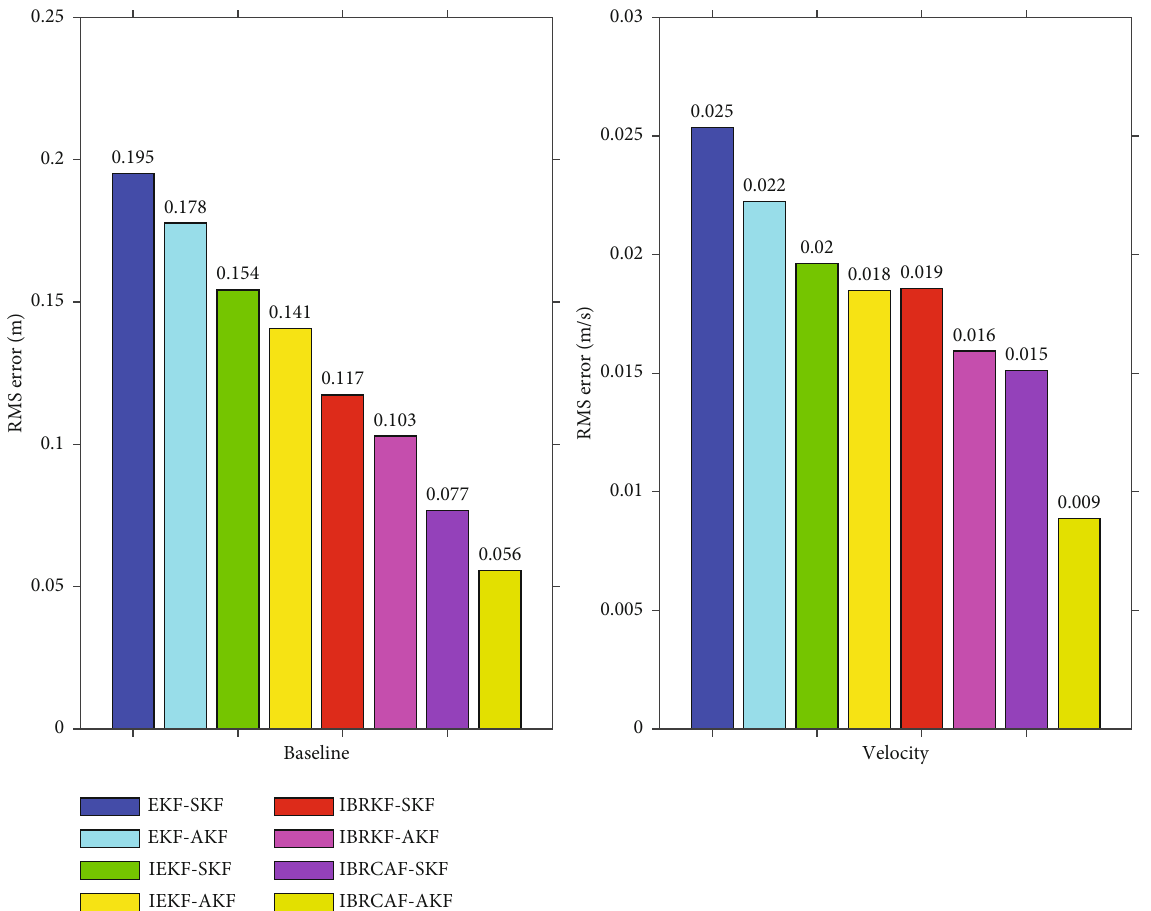
Figure 24: The RMS errors of baseline and velocity of various algorithms (Data